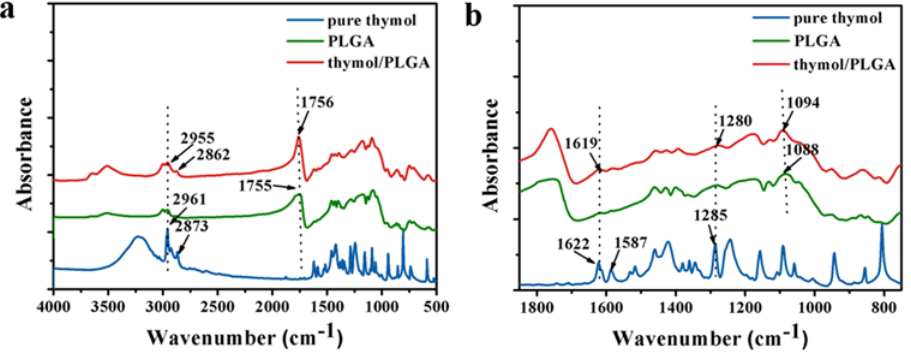
Figure 3. FTIR spectra of free thymol, PLGA, and thymol-loaded PLGA microparticles in the range of 4000–500 cm − 1 ( a ) and 1800–800 cm − 1 ( b